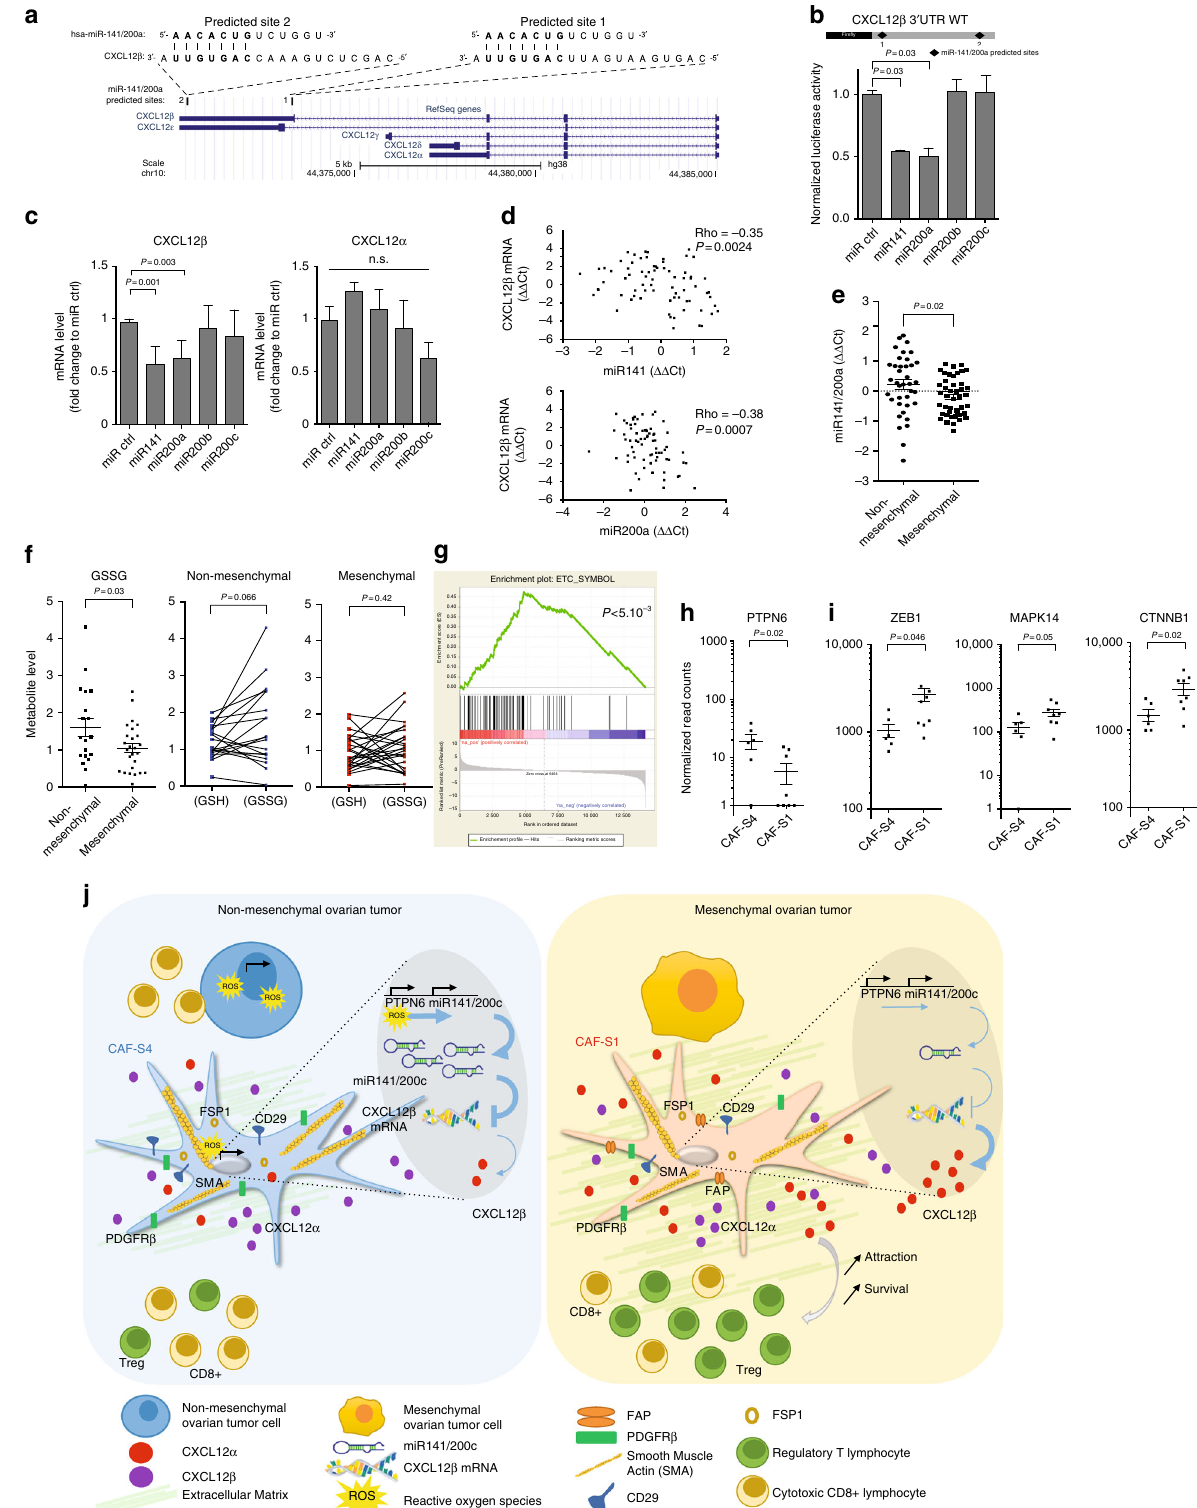
Table 1). For surface staining, detecting proteins located at the plasma membrane and compatible with RNA extraction (used in Fig. 5a), cell suspensions were stained immediately after dissociation of HGSOC samples and fi ltration by using